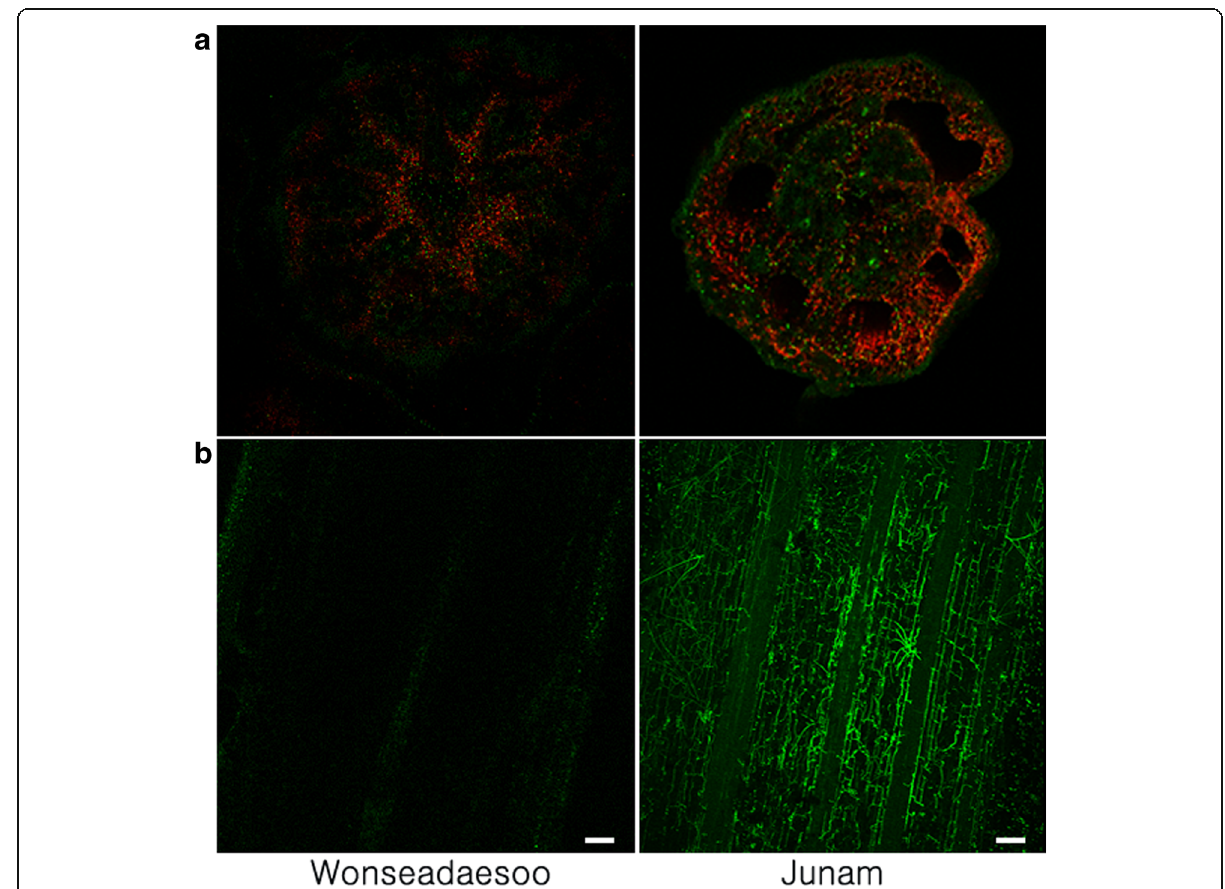
Fig. 2 Confocal imaging of Wonseadaesoo and Junam rice plants infected with CF283GFP Fusarium fujikuroi isolates. a Radial and ( b ) longitudinal sections of the basal stem (Scale bar = 20 μ m)